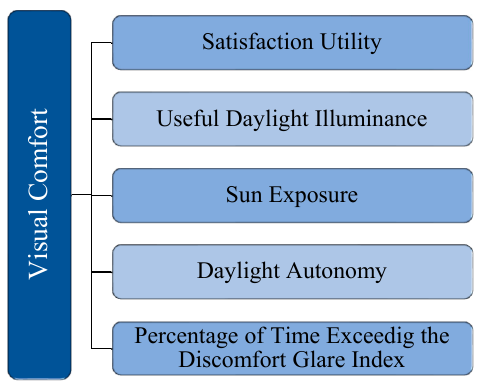
Figure 8. Visual comfort indicators.